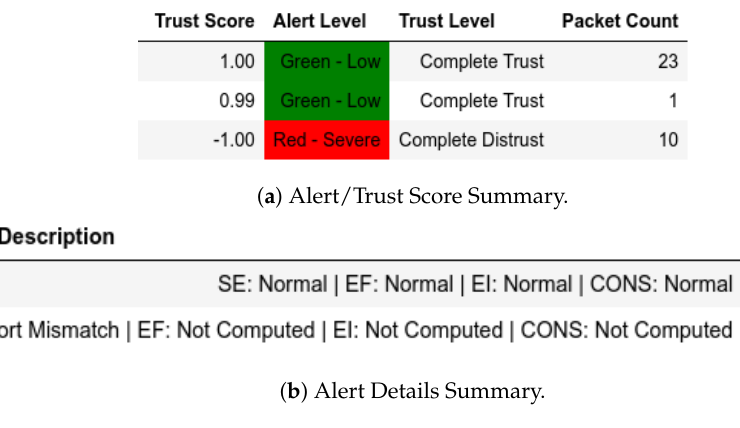
Figure 18. Client: EPM dataset internal test- H s in command-and-control capture.